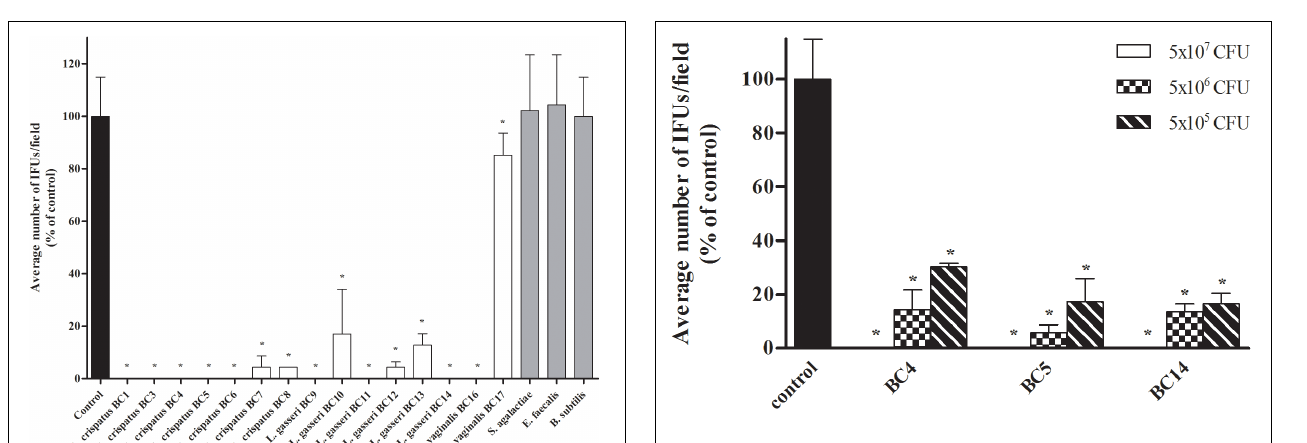
FIGURE 2 | Dose–response effect of Lactobacillus cells on C. trachomatis infectivity in HeLa cells. Exclusion experiments were performed at different doses (5 × 10 7 , 5 × 10 6 , and 5 × 10 5 cells) for L. crispatus BC4, L. crispatus BC5, and L. gasseri BC14 strains. C. trachomatis infectivity was evaluated as number of IFUs/microscopic field. Results were expressed in percentage compared with control, taken as 100% (black bars). Bars represent median values, error bars represent median absolute deviations. Statistical significance was calculated vs. control. ∗ P ≤